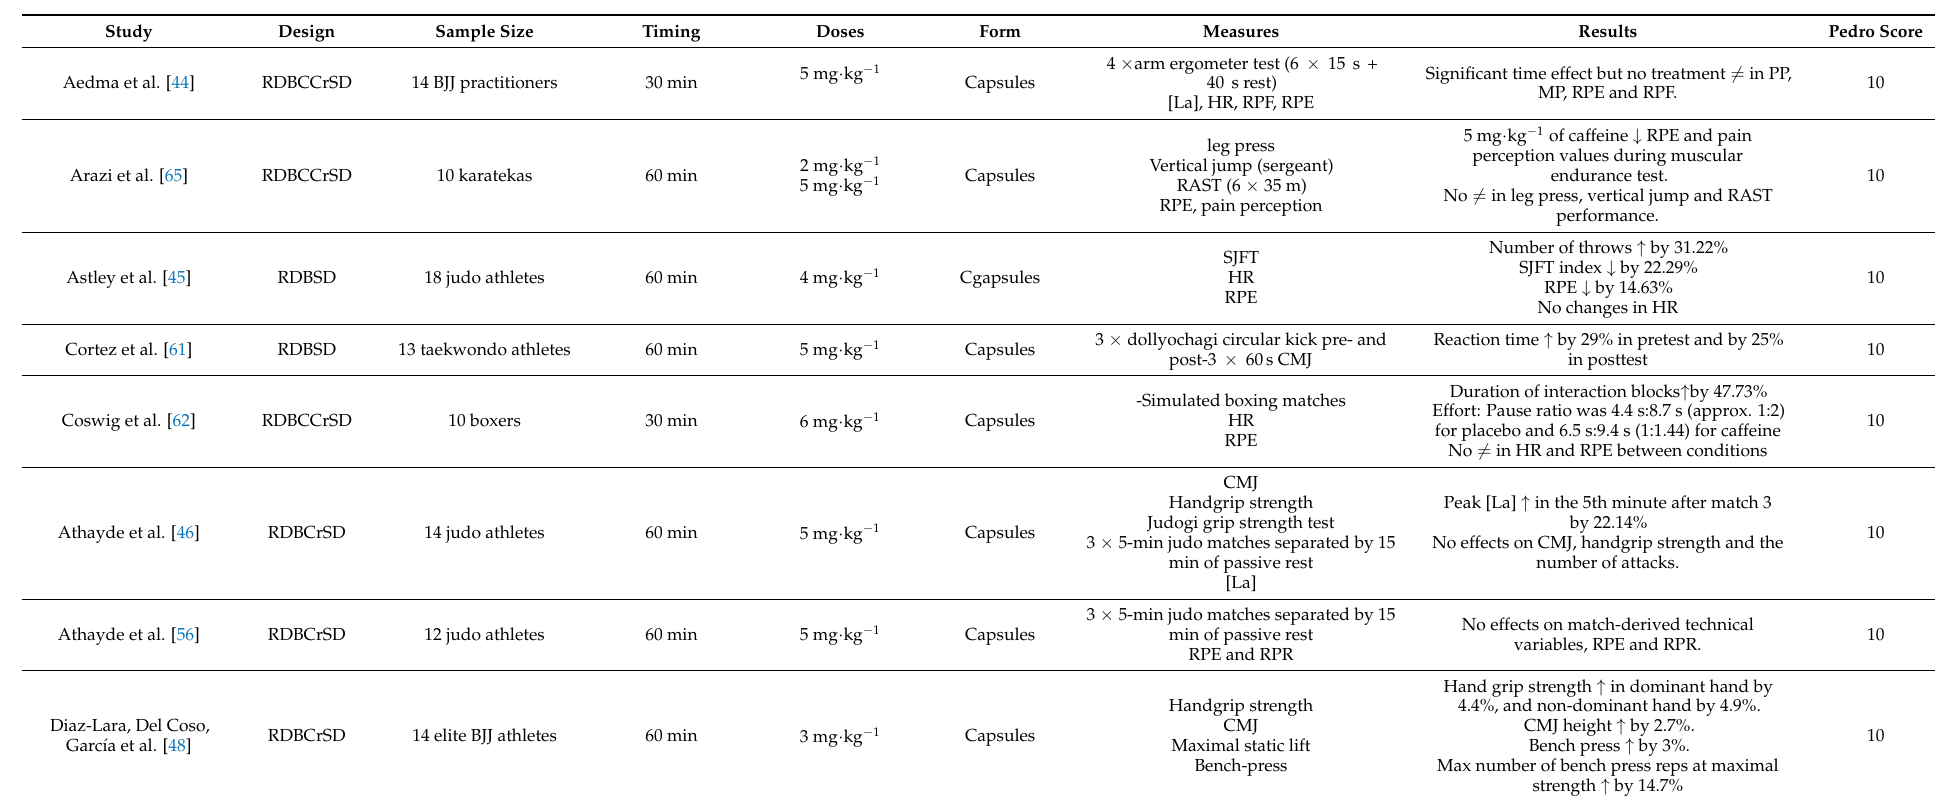
Table 2. Summary of the studies examining the impacts of acute caffeine supplementation on combat sports performance